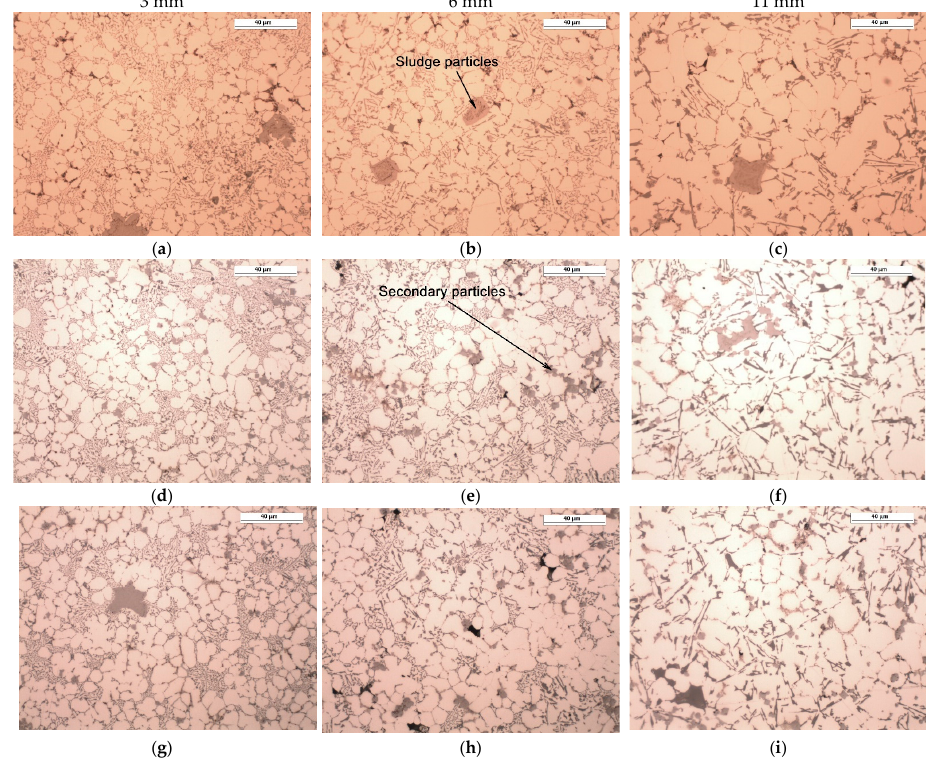
Figure 9. Microstructure of the tested Al-Si-Cu alloy in areas with different wall thicknesses in test castings according to Table 3: series A ( a – c ), series E ( d – f ), and series K ( g – i ); unetched.